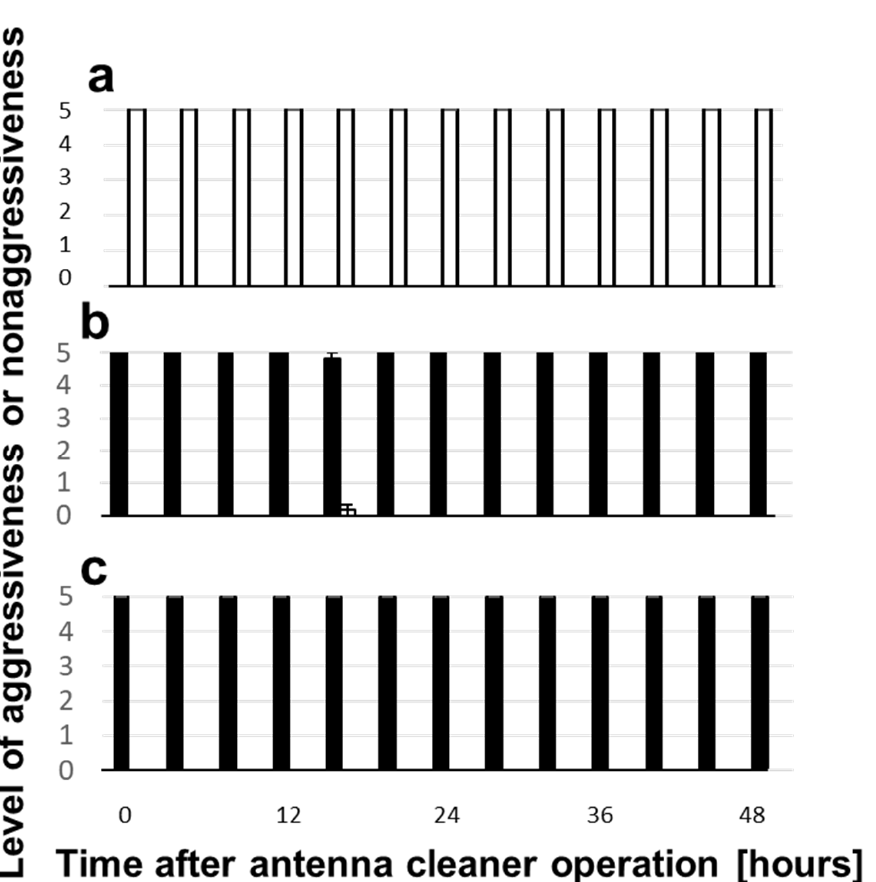
Figure 5. Aggressiveness and nonaggressiveness changes in the self-grooming nonlimited ants. Levels of aggressiveness (black columns) or nonaggressiveness (white columns) in the self-grooming nonlimited ants toward conspecific nestmates ( a ), non-nestmates ( b ), and heterospecific workers ( c ) after the sham operation.